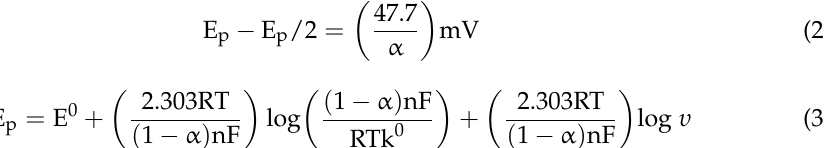
Figure 5. ( A ) Cyclic voltammograms of the THP (0.1 mM) in different electrolytic solutions in the CuO-GO/CPE; t acc = 10 s; scan rate = 0.05 Vs −1 . ( B ) Plot of E pa vs. pH. ( C ) Change in peak current with the